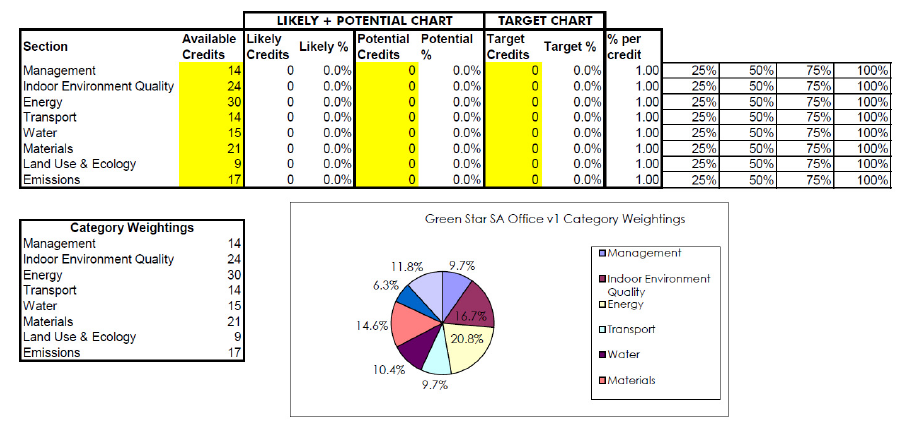
Figure 7. Category weightings for 4 and 6 Green Star.